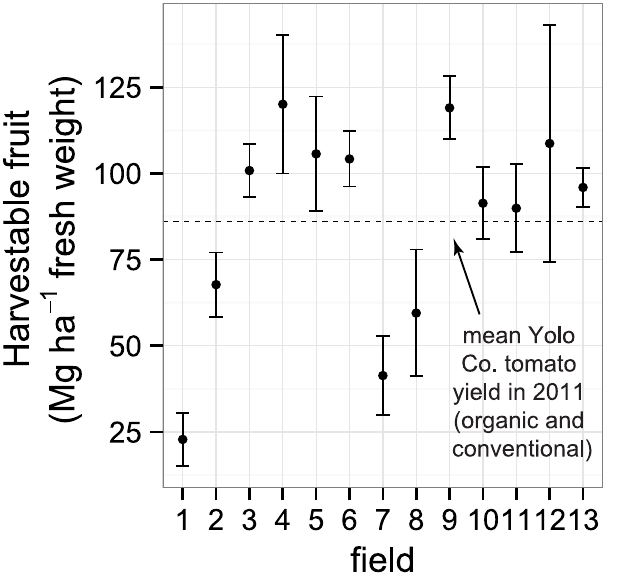
dotted line represents the overall Yolo County average processing tomato yield in 2011 (86.1 Mg ha -1 ), including both conventional and organic tomato